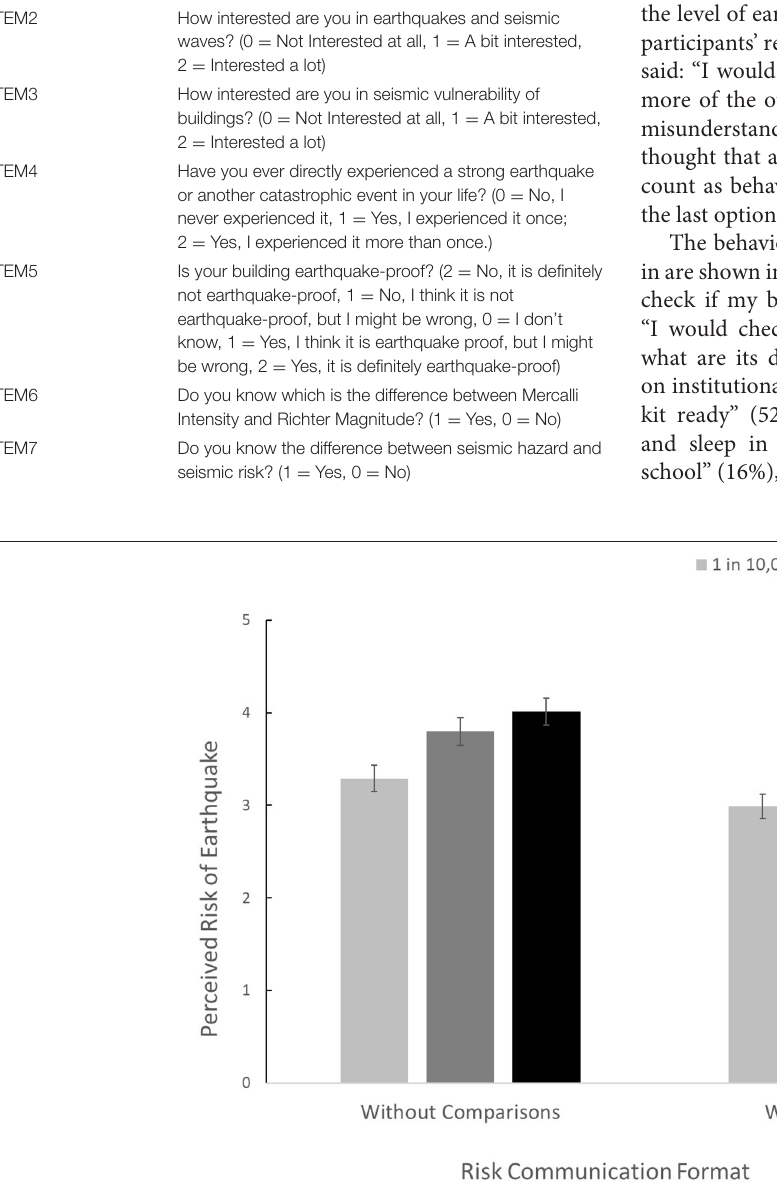
Frontiers in Communication |